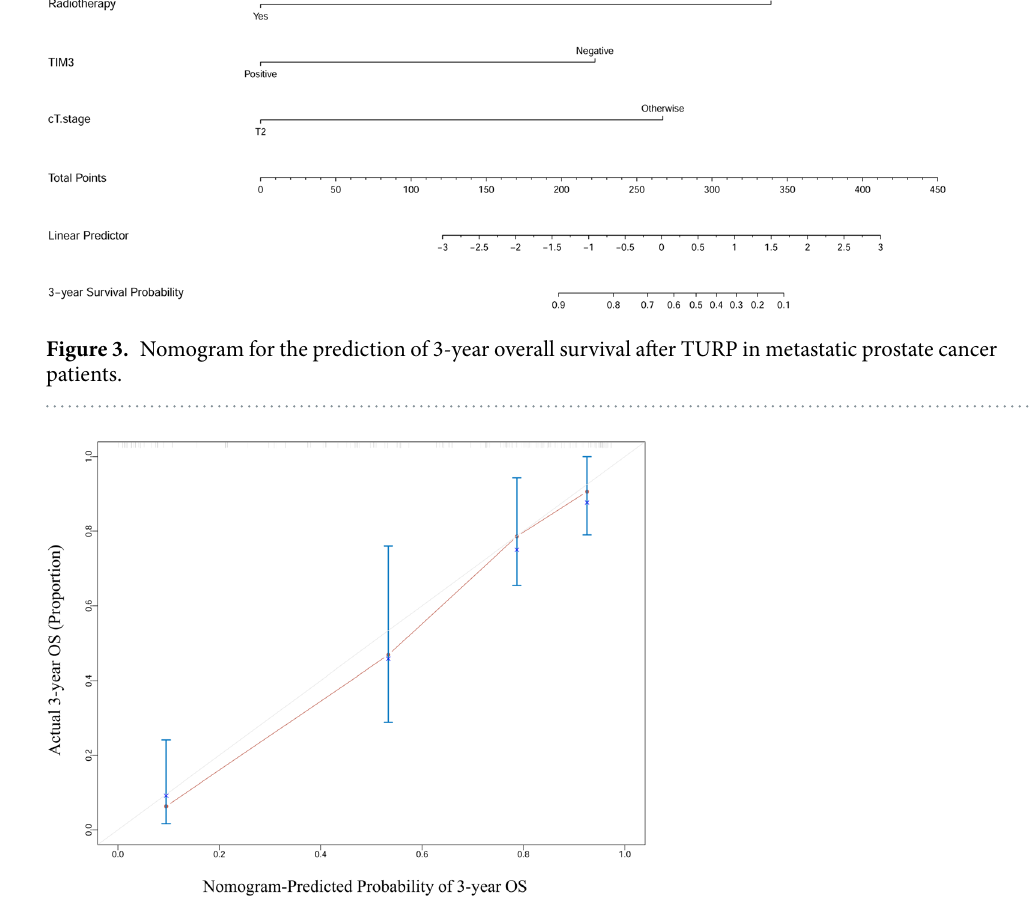
Figure 4. Calibration curve of the nomogram for the prediction of 3-year overall survival after TURP in metastatic prostate cancer